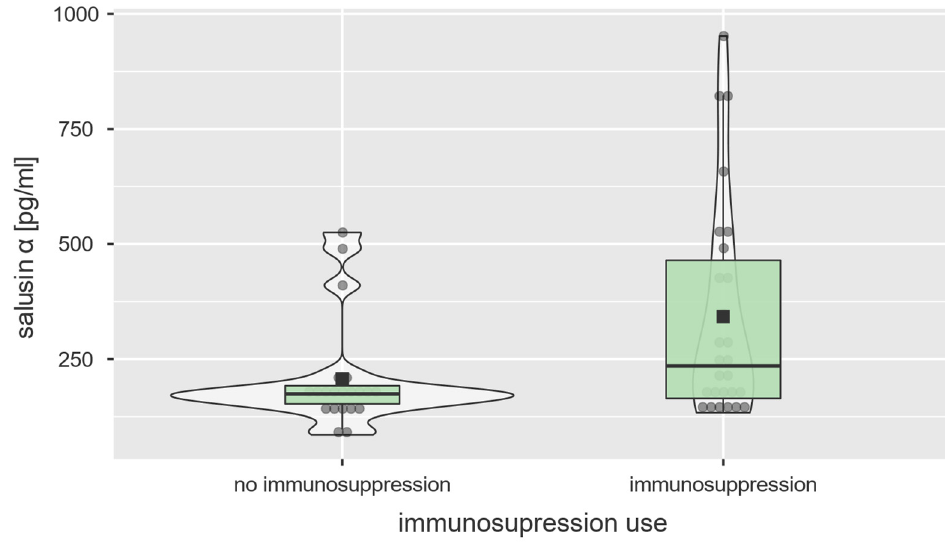
Figure 4. Association between serum salusin- α levels [pg/mL] and therapy used (U = 176.0; p = 0.026). Table 4. Salusin- α concentrations in the experimental group—patients treated with either vasodila- tors only or with vasodilators in combination with immunosuppressive agents.